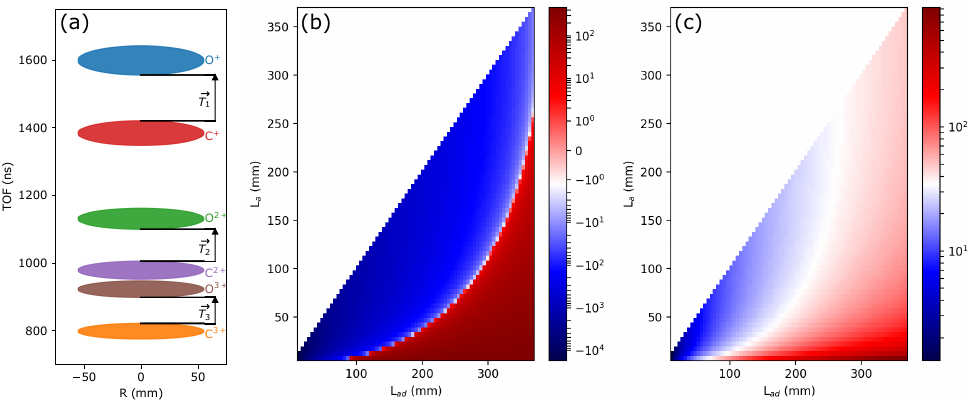
Figure 8. Mass resolving power and electric field dependence on the acceleration length L a and acceleration-plus-drift length L ad . ( a ) Simulated “TOF vs. R” plot of C q + and O q + ions detected with a certain spectrometer configuration, with q = 1, 2 and 3. The vector the largest C i + TOF to the point of the smallest O i + TOF. ∑ 3 resolving power. ( b ) The dependence of the mass resolving power ∑ 3 length L a and acceleration-plus-drift length L ad . ( c ) The dependence of the required electric field strength (V/mm) on the acceleration length L a and acceleration-plus-drift length L ad